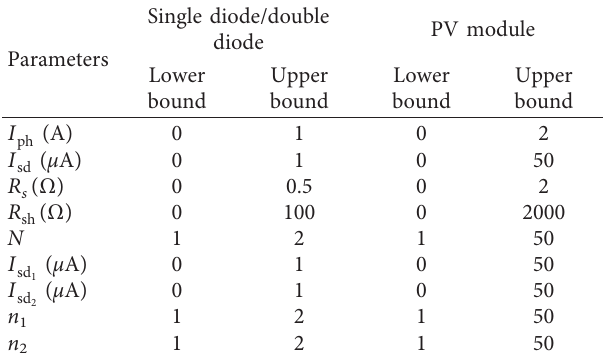
Table 1: Bounds of parameters for three different models.